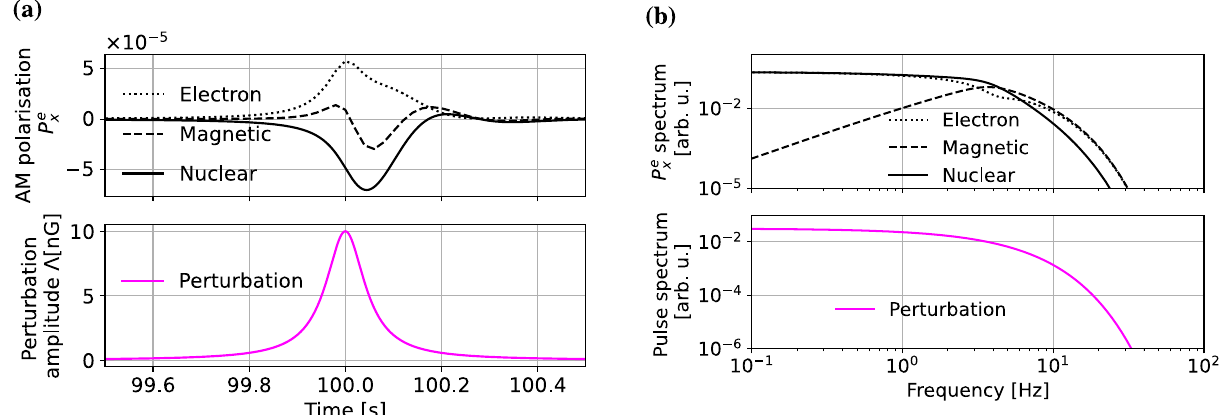
Figure 2. (a) Temporal responses of the co-magnetometer to pseudo-magnetic electron (dotted line), pseudo- magnetic nuclear (solid line) and magnetic (dashed line) spin perturbations. The bottom subplot shows the 50-ms Lorentzian-shaped perturbation common for all types of couplings. (b) Spectra of the co-magnetometer responses to pseudo-magnetic electron (dotted line), pseudo-magnetic nuclear (solid line) and magnetic (dashed line) spin perturbations assuming the same amplitude of the perturbations in effective pseudo-magnetic magnetic field units. For the reference, the bottom subplot shows spectrum of 50-ms Lorentzian pulses. All spectra were obtained with Fast Fourier Transform of 200-s long time series of the responses and